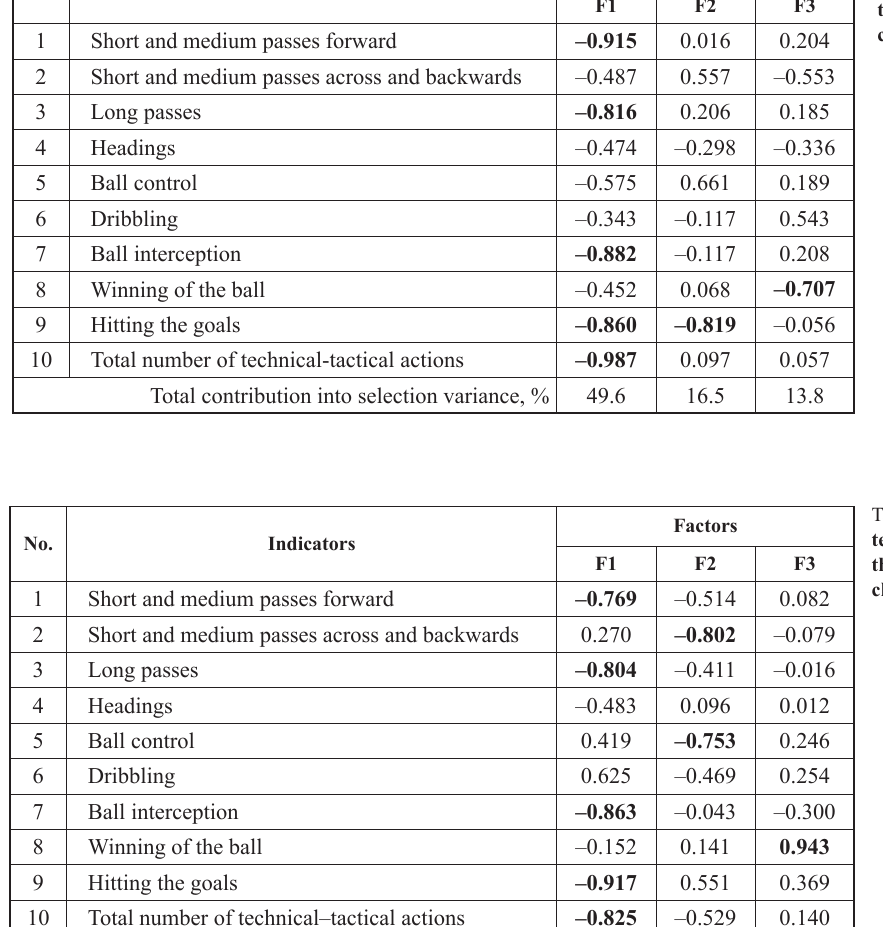
Table 1. Factor structure of technical-tactical actions during the first round of the country’s championship